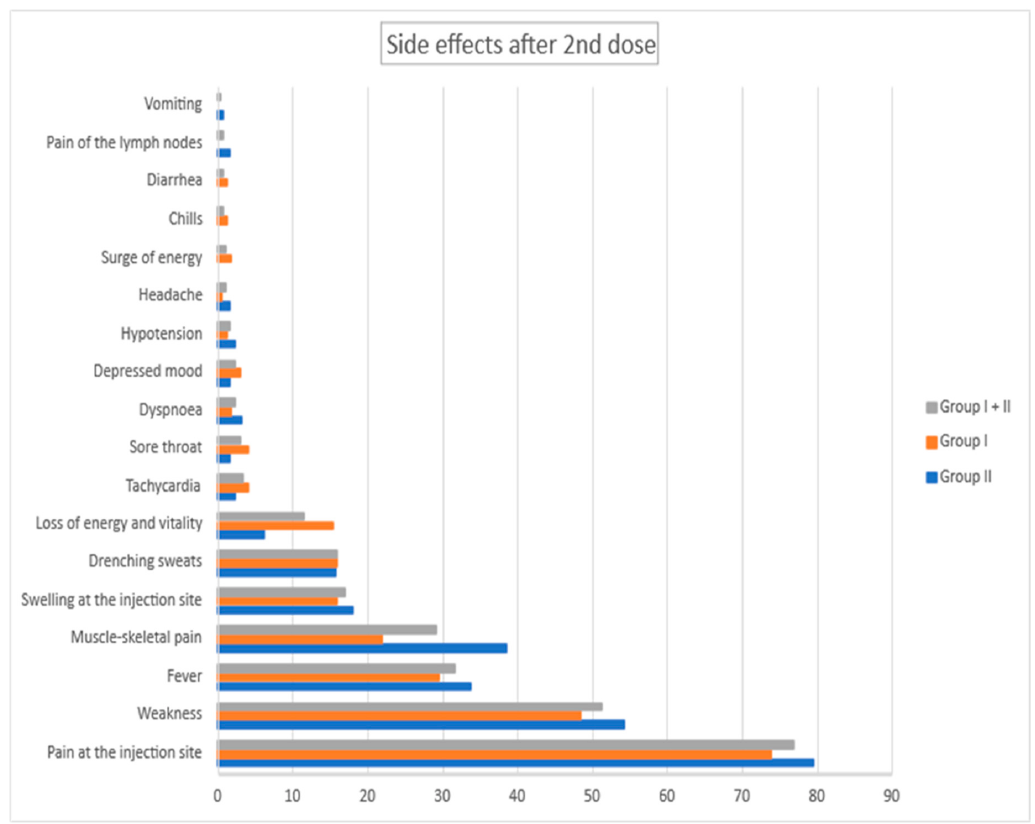
Figure 3. Side effects after 2nd dose for group I and group II in